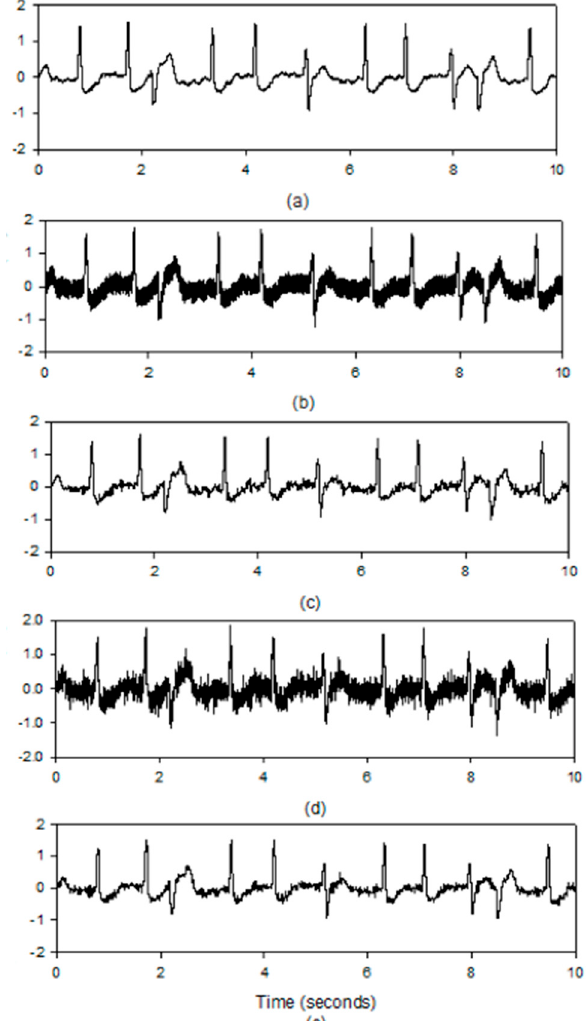
Figure 8. The arrhythmic ECG signals, ( a ) the original ECG signal with two PVC beats, ( b ) the ECG with PLn, ( c ) the denoised ECG with PLn, ( d ) the ECG with EMG noise ( e ) the denoised ECG with EMG noise.